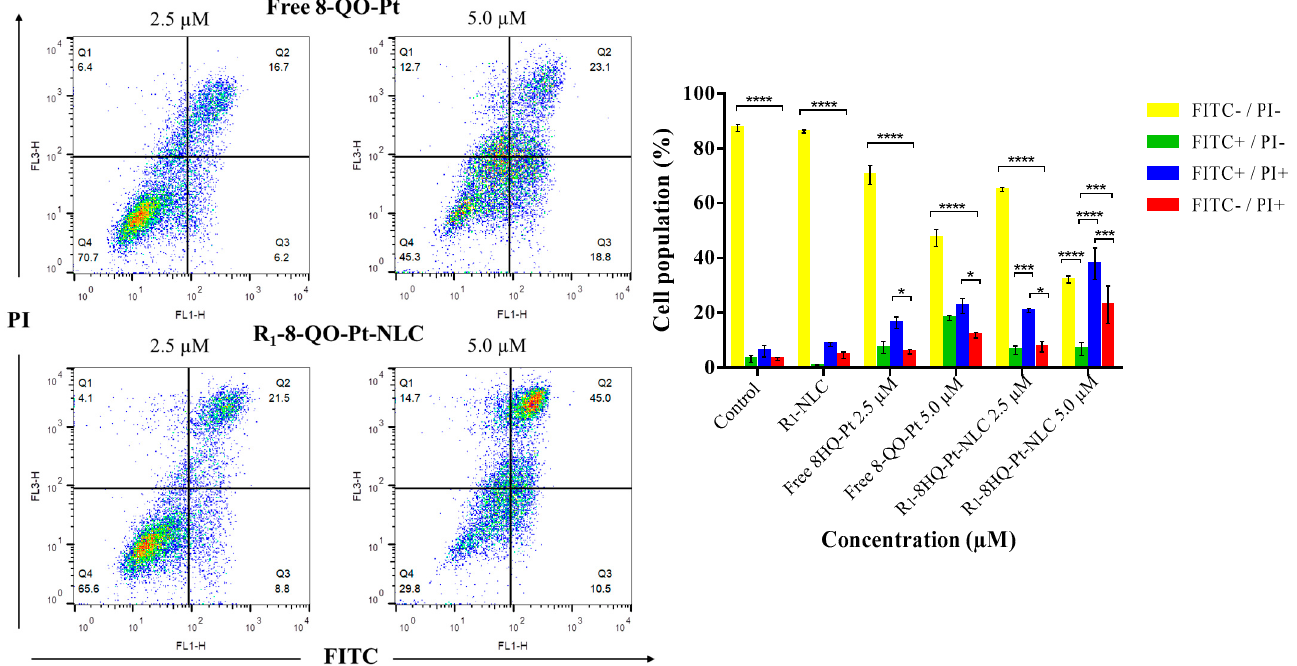
Figure 5. Apoptosis effect of the free 8-QO-Pt compound and R 1 -8-QO-Pt-NLC at 2.5 µM and 5.0 µM after 24 h incubation with HT-29 cells. Data are shown as mean ± SD ( n = 3). (* p < 0.01; *** p < 0.0002; **** p < 0.0001).